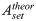
Performance of the motif 2 zero-order based controller with respect to linear increases in V and k3.The controller is able to defend Asettheor successfully, but breaks down when k3V reaches k2/Asettheor (Eq 48). Rate parameters: k2 = 1 × 105, k4 = 1 × 10−3, k8 = 1.0, k9 = 2.0, k10 = k11 = 1 × 10−6. Initial conditions: A0=Asettheor=2.0, E0 = 1.0, M0 = 1 × 106, P0 = 0.0, V0 = 25.0, k3,0 = 2.0. V˙=2.0 (phase 2 and phase 3), k3˙=1.0 (phase 3).